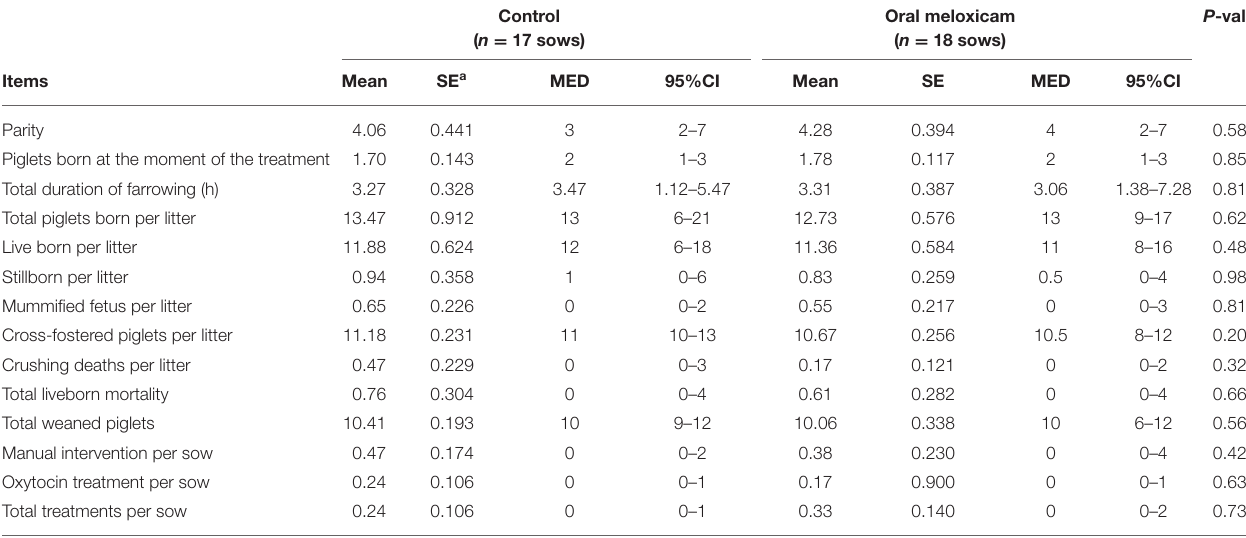
TABLE 1 | Mean, standard error (SE), median (MED) and 95% confidence intervals for median (95% CI) of performance parameters and treatment records studied in the control and oral meloxicam groups during the whole trial period (from farrowing to weaning at 21 days).